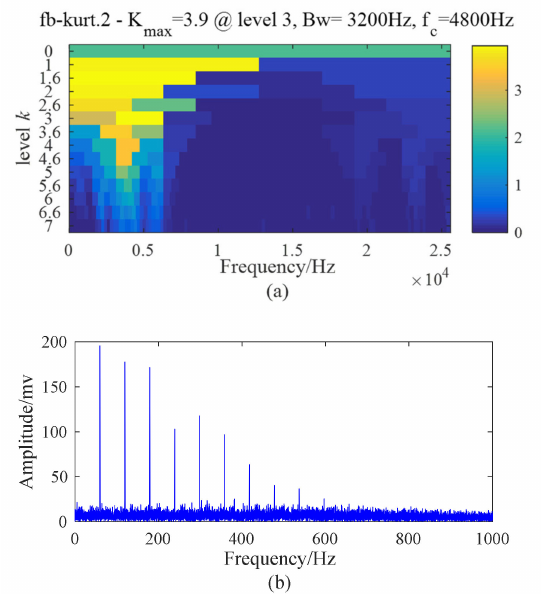
Figure 24. The diagnosis result of the collected signal of the bearing with 1 mm outer race fault processed by the Fast Kurtogram (FK) method: ( a ) the kurtogram result; ( b ) the squared envelope spectrum result.